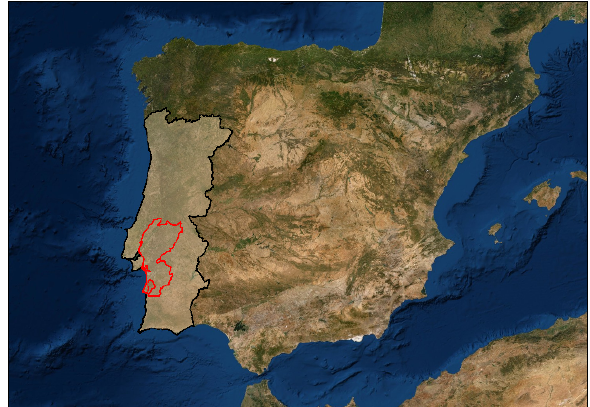
Figure 2. Test area of Portugal represented by the red